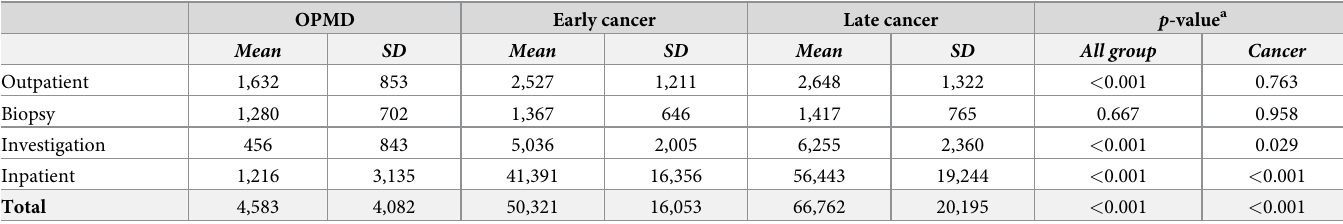
Table 2. Unadjusted healthcare provider cost per patient in the initial phase (in